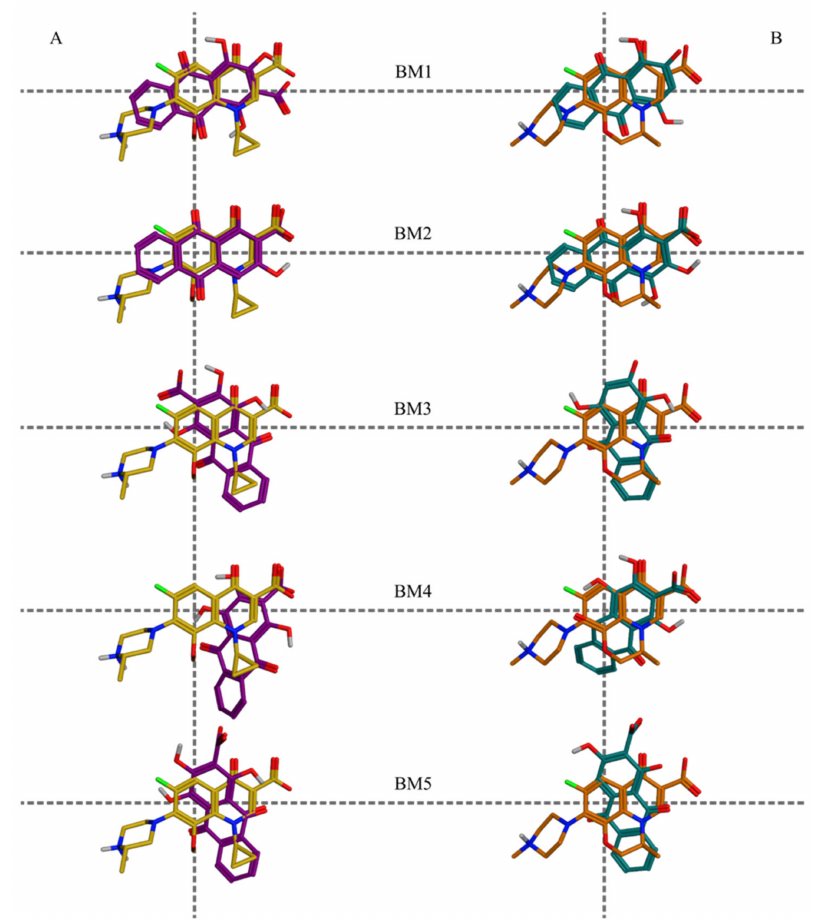
Figure 3. Shared binding modes predicted in both enzymes—DNA gyrase and DNA topoisomerase IV: ( A ) overlay on (S)-gatifloxacin (yellow) of the following hydroxyanthraquinones (dark violet), pseudopurpurin (BM1, BM3, BM4, and BM5) and munjistin (BM2); ( B ) overlay on (S)-levofloxacin (orange) of the following hydroxyanthraquinones (teal), purpurin (BM1 and BM3), pseudopurpurin (BM2 and BM4), and munjistin